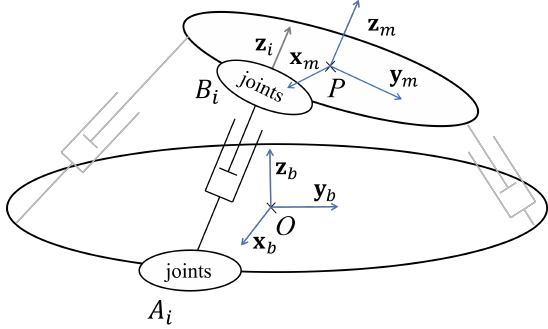
Figure 3. Definition of used parameters for PKM with telescopic